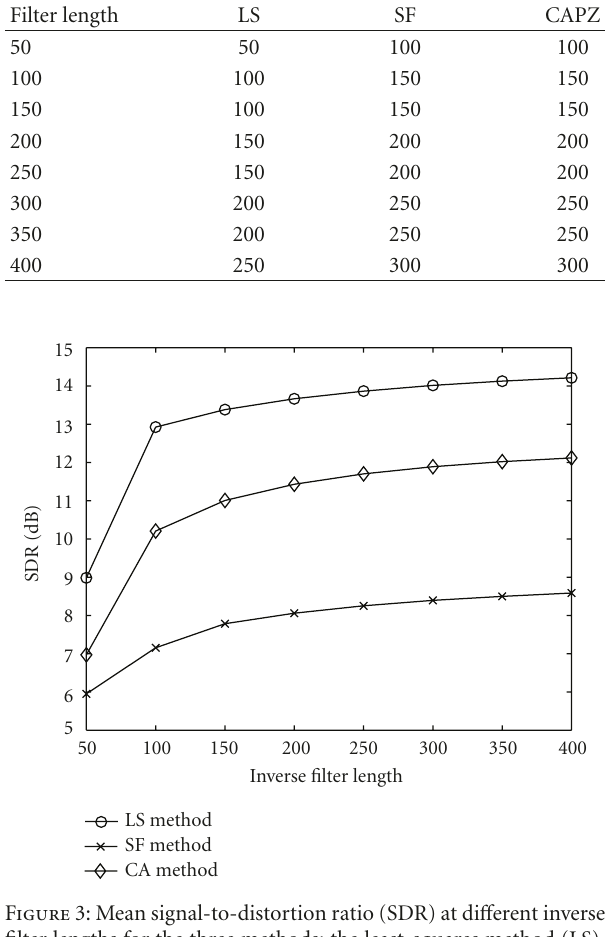
Table 3: Optimal delay d at various inverse filter lengths (in samples) for the three methods: the least-squares method (LS), the single-filter structure method (SF), and the CAPZ method.